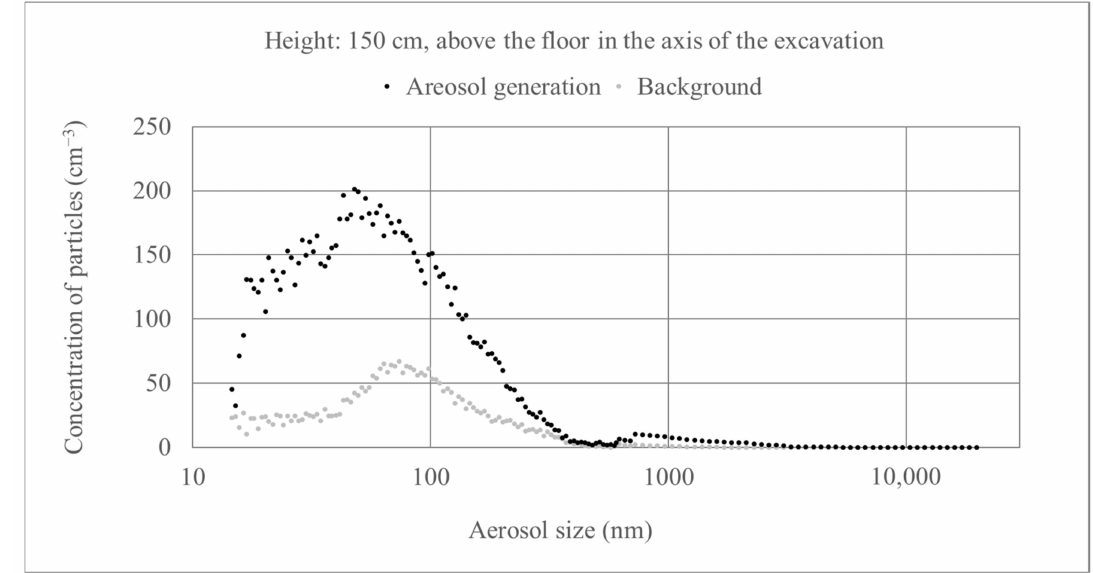
Figure 10. Particle size distribution before and during operation of the aerosol generator. Generator efficiency: 17 cm 3 of